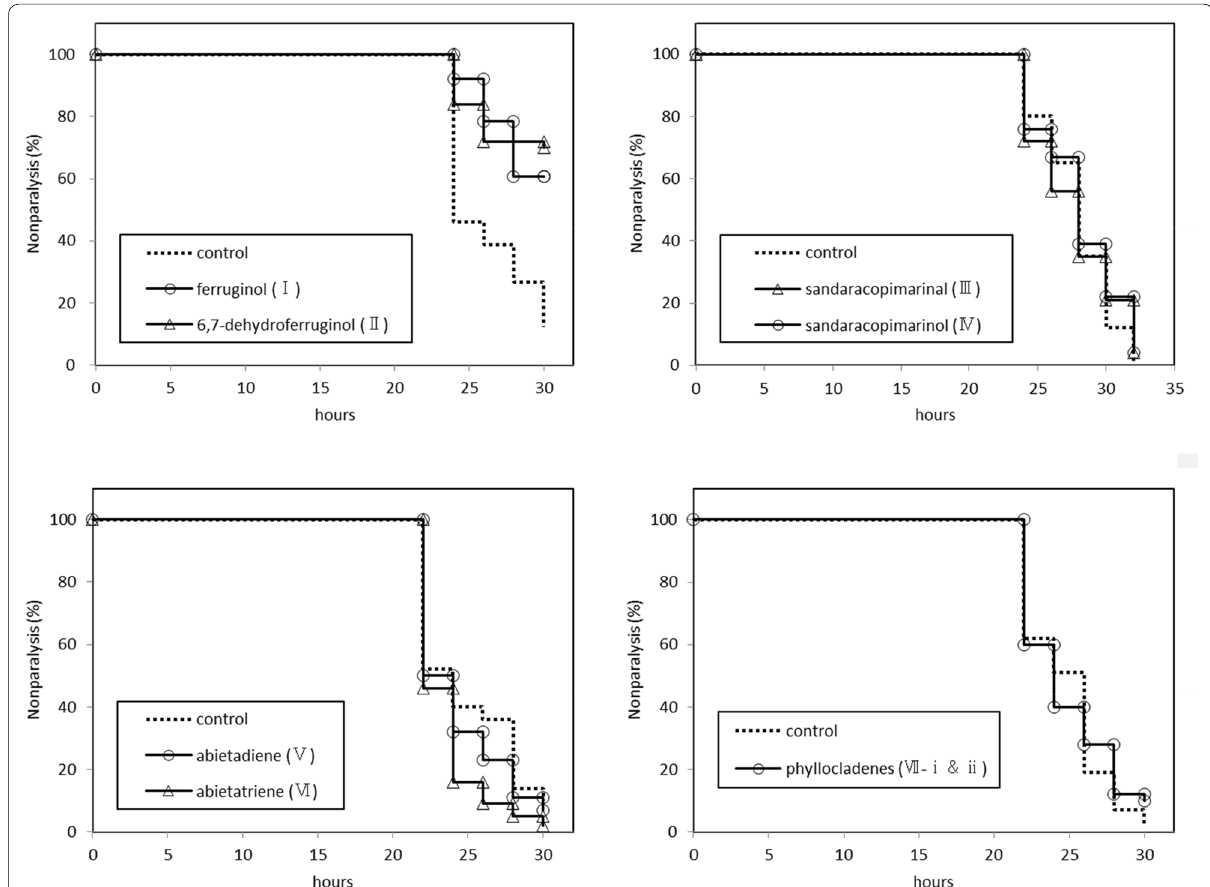
Fig. 3 Time course of paralysis assays in C.elegans CL4176 fed with sugi wood